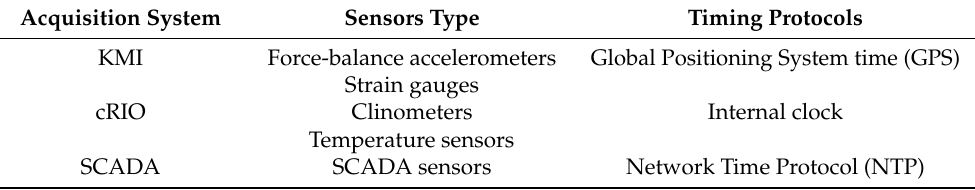
Table 1. Tower monitoring systems of wind turbine 1 and corresponding timing